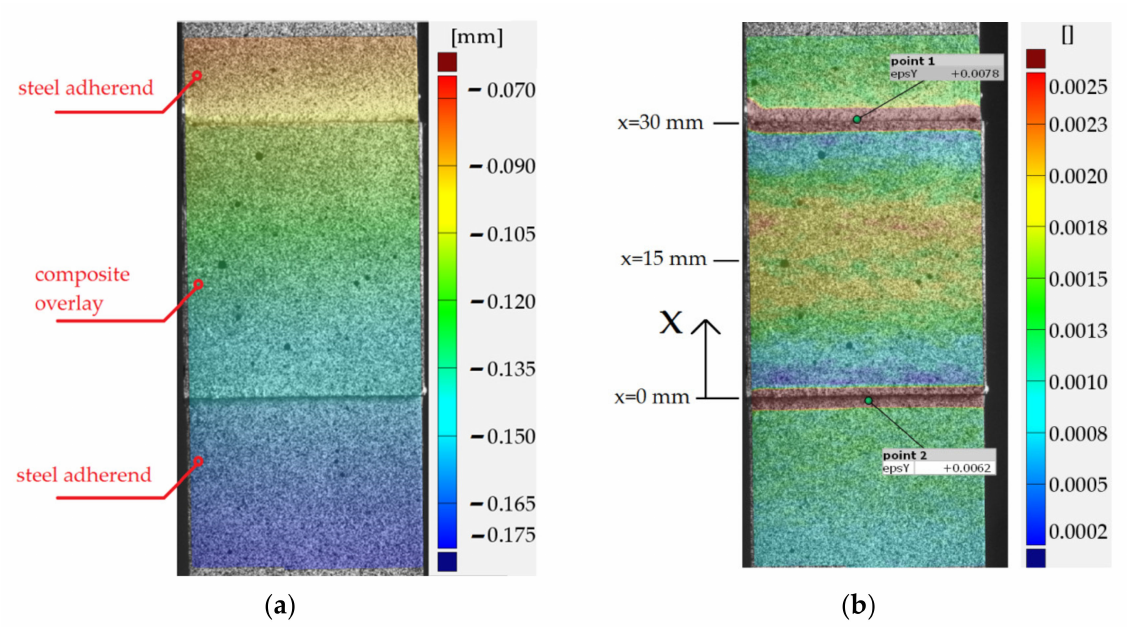
Figure 11. Results from DIC analyses for double-lap joint with S&P C-Laminate 150/2000 overlays: